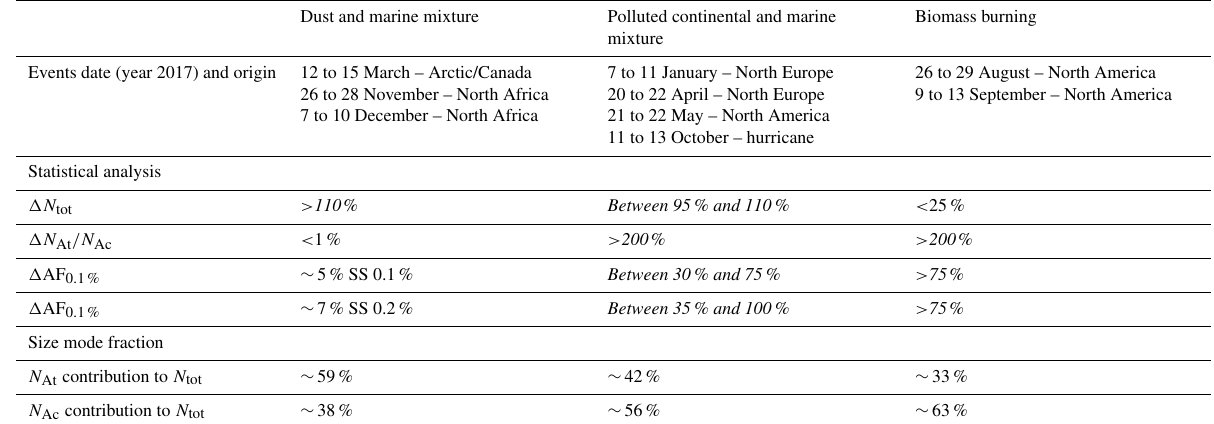
Table 3. Summary of the characteristics of each type of multiday aerosol plume transport event. Italic values indicate statistically significant (cid:49)